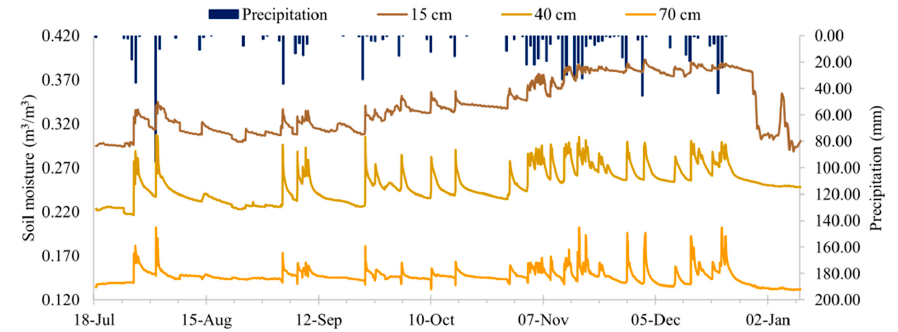
Figure 3. Continuously measured data of cumulative daily precipitation and soil moisture at three soil depths between 18 July 2019 and 10 January 2020. The precipitation amount of 29 events varied between 10.2 and 60.3 mm, while rainfall duration ranged between 40 min and 25 h. The highest monitored discharge was 60.3 L/s (Table 1). However, average and minimum discharge during this period were 3.8 (±1.6) and 1.3 L/s, respectively. The range of NO 3 -N concentration during 18 events was 0.41 – 3.28 mg/L, with an average value of 0.91 (±0.39) mg/L. Volumetric water content decreases with depth. Average values of soil moisture, monitored during the study, were 0.340 (±0.03), 0.250 (±0.02), and 0.147 (±0.01) m 3 /m 3 at 15, 40, and 70 cm, respectively. The dataset was split into 29 individual events starting with the first recorded precipitation. The events ended four hours after the last recorded precipitation data. For all 29 events, precipitation, discharge, and soil moisture data are available, while due to operational conditions (calibration of the sensors) and some technical problems, water chemistry data are available for only 18 events (Figure 2, Table 1).